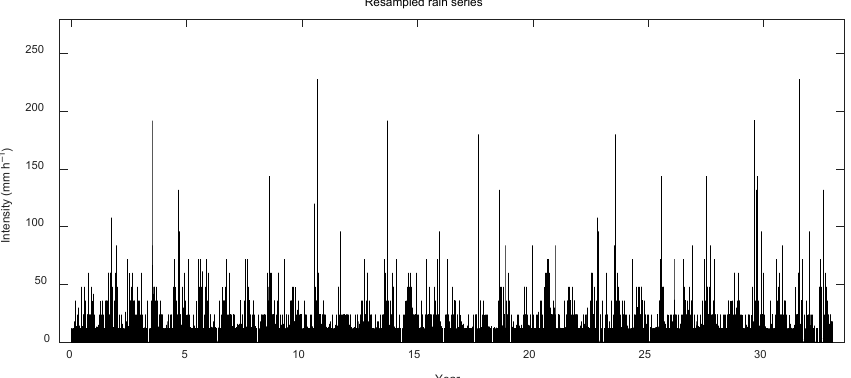
Figure 6. Time series example of resampled rainfall series. The temporal resolution of rainfall data is